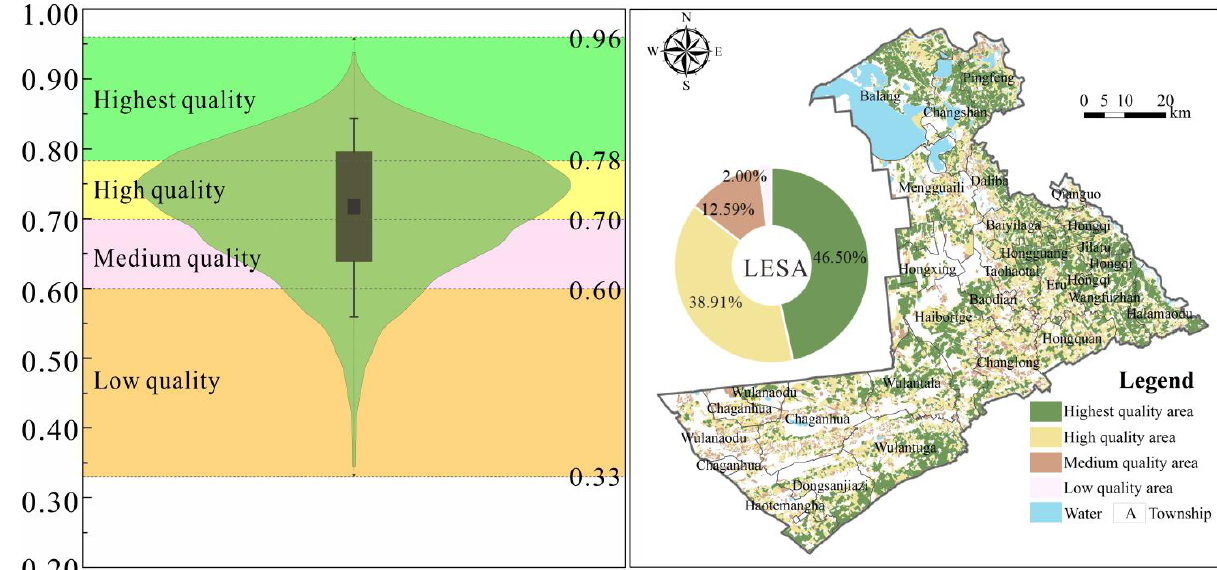
Figure 5. The distribution and proportion of LESA gradation in Qianguo County.